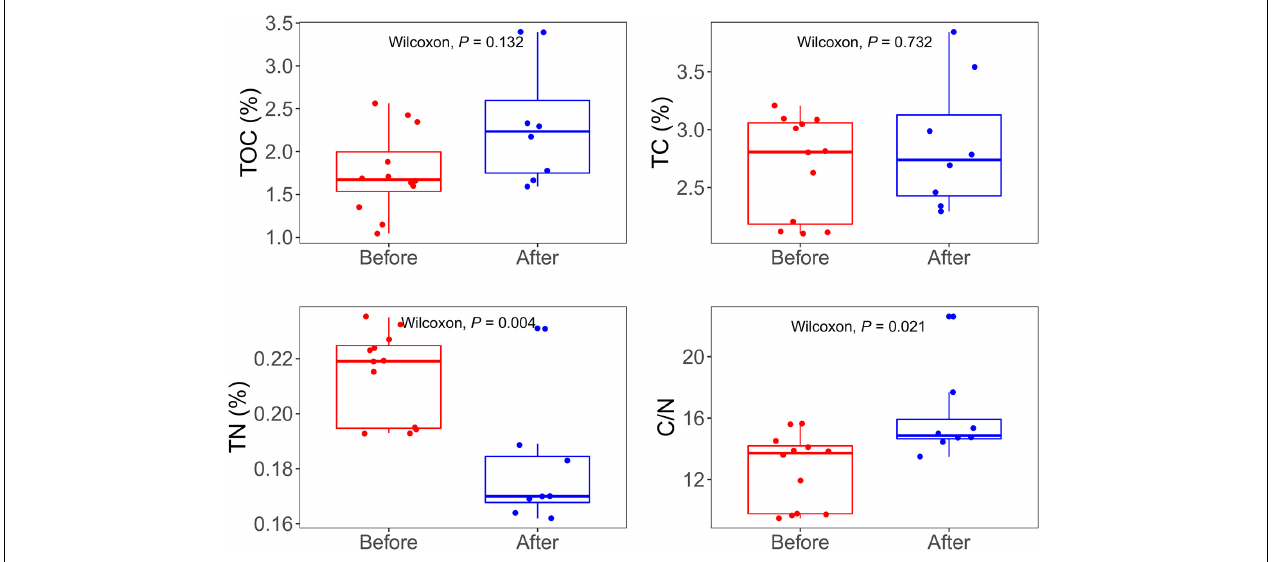
FIGURE 1 | Total dissolve carbon (TOC), total carbon (TC), total nitrogen (TN), and rate of carbon nitrogen (C/N) concentrations in samples before and after snowfall disturb. Each dot represents an individual sample. Significantly higher concentrations of TN were observed in the samples before snowfall, while a significantly higher ratio of C/N was in the samples after snowfall (Wilcoxon rank-sum test, P < 0.05).